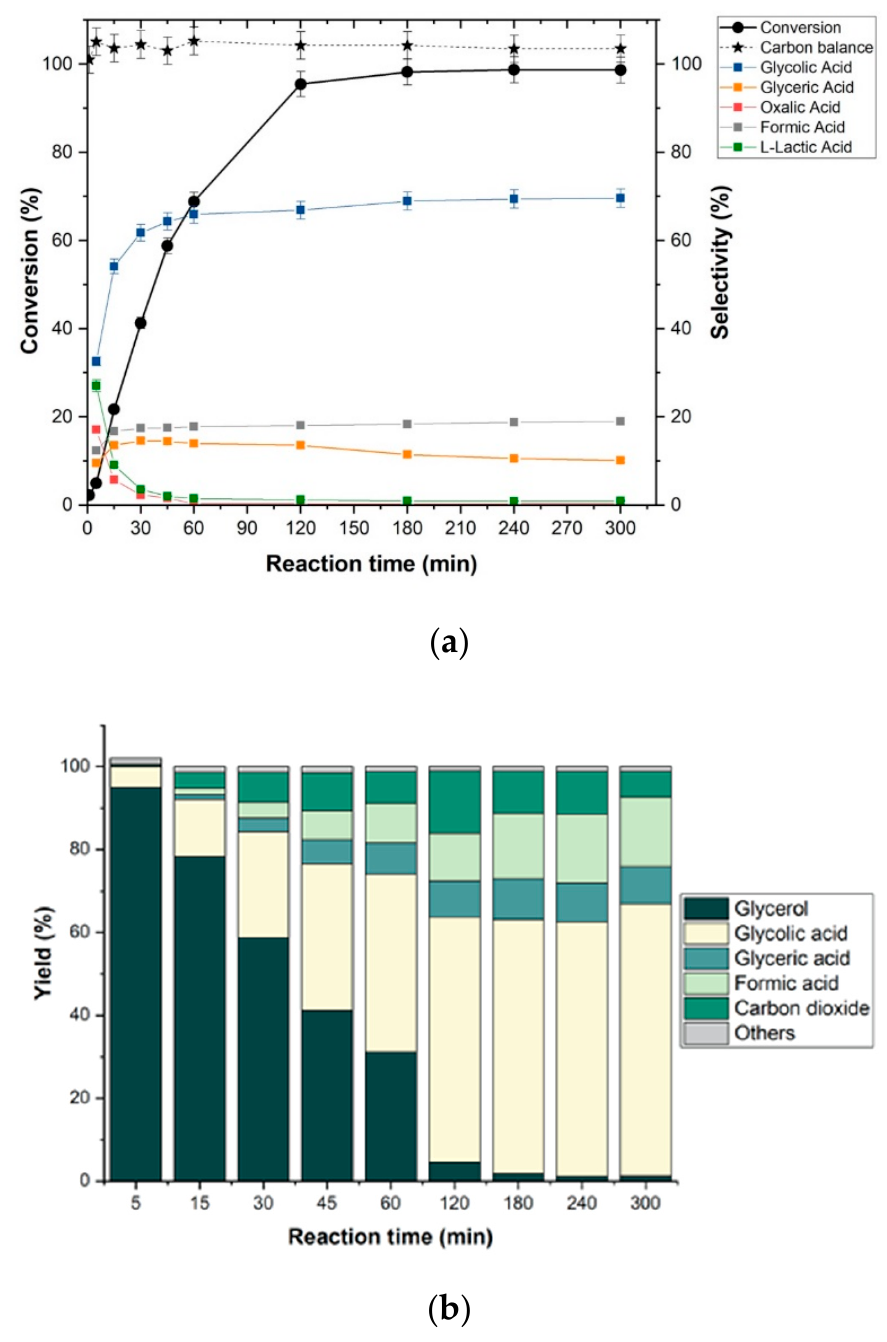
Figure 5. Experimental results obtained for benchmark test at previously determined operating conditions: 0.3 M glycerol solution, 60 °C, 5 bar, 0.5 g of catalyst, and a NaOH/glycerol molar ratio of 4 ( a ) glycerol conversion and products selectivity and ( b ) products yield.